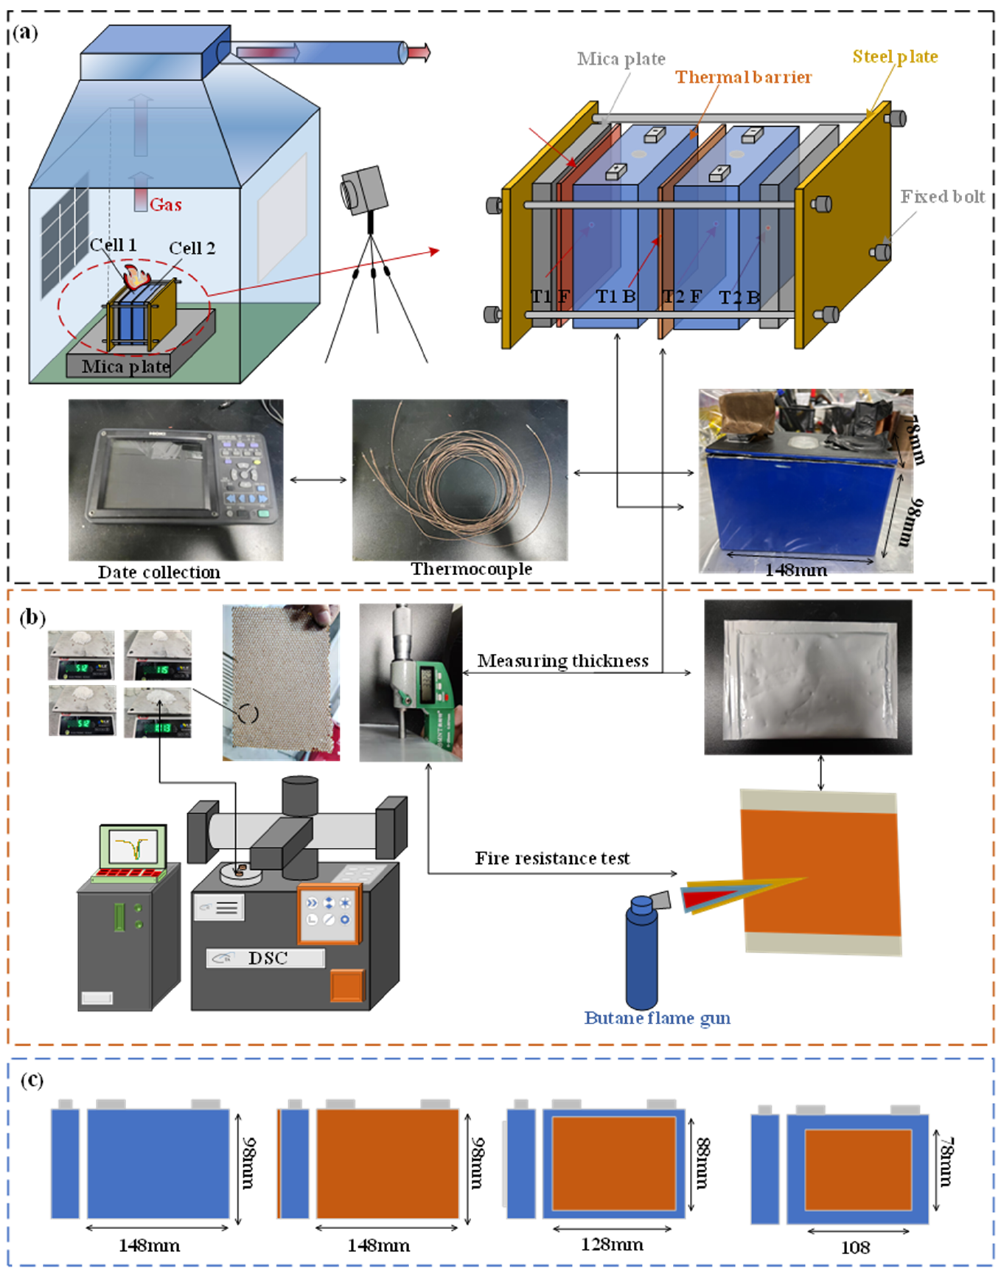
Figure 2. Schematic of the experimental setup: ( a ) thermal runaway platform and thermocouple; ( b ) testing equipment for PCM; and ( c ) different areas of thermal barrier.